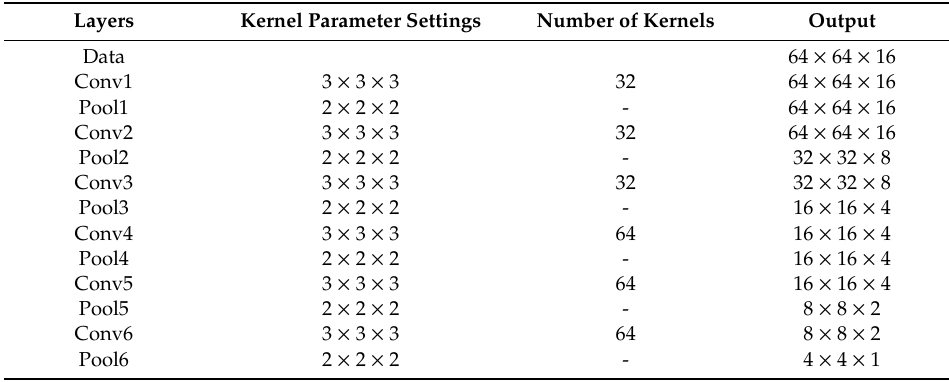
Table 1. The detailed configuration of Basic